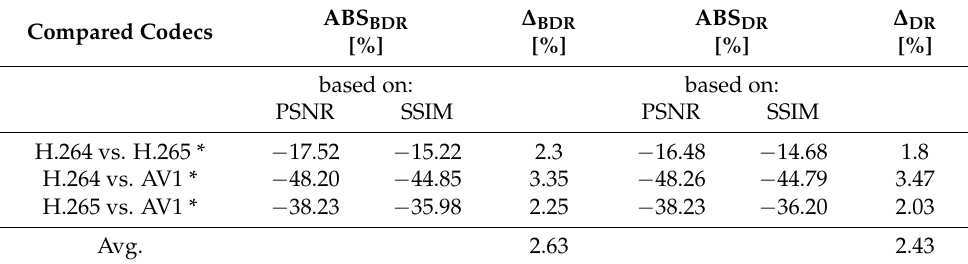
Table 6. Bitrate savings for the ‘ReadyStGo’ video